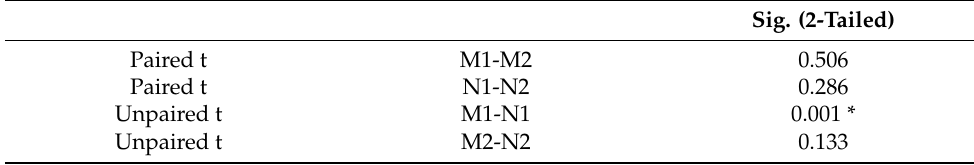
Table 3. Summary of